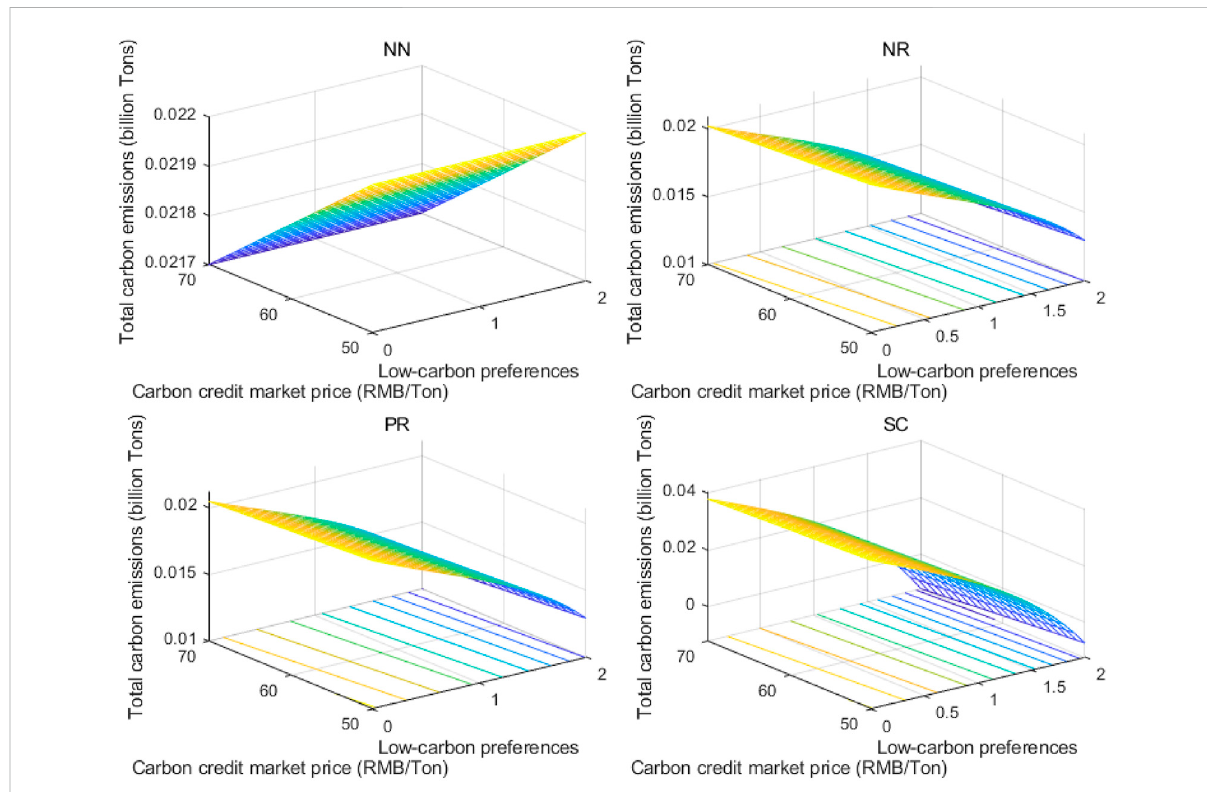
FIGURE 10 Total carbon emissions responses to customers ’ low-carbon preference and carbon trading price.